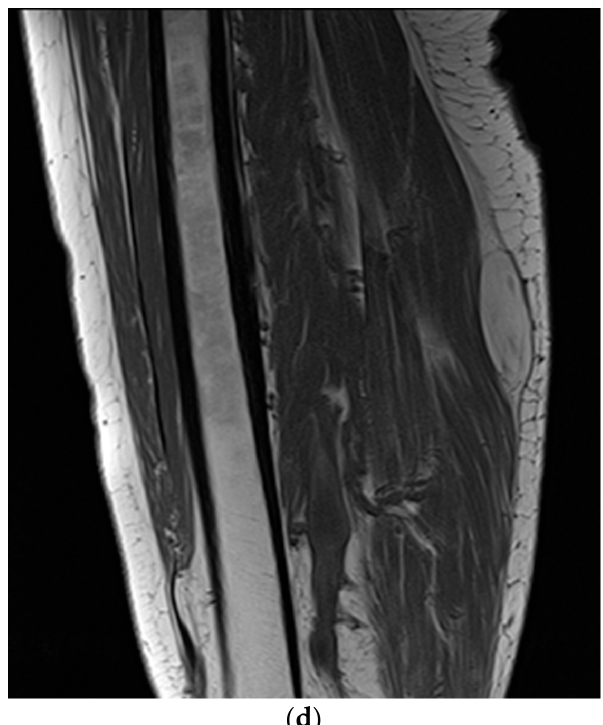
Figure 4. A 79-year-old woman operated on for a high-grade liposarcoma. At follow-up, both US ( a ) and MRI ( b – d ) detected a solid nodule in the posterior aspect of the thigh with prevalent fatty content near the surgical area. Both US and MRI were reported as consistent with recurrence; however, pathology did not show any malignant tissue after surgery.